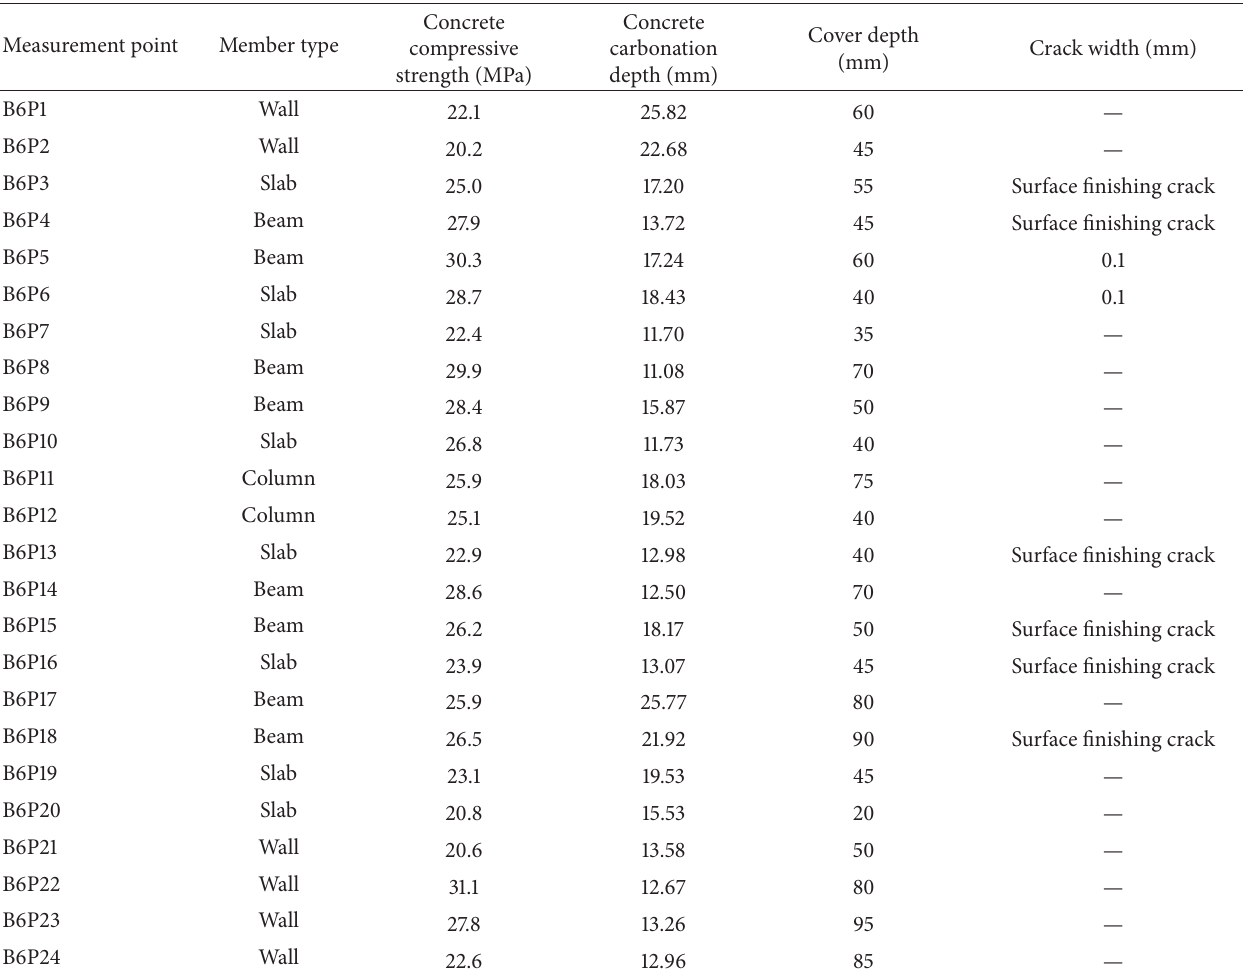
Table 8: Field investigation data (Building 6, construction completion year: